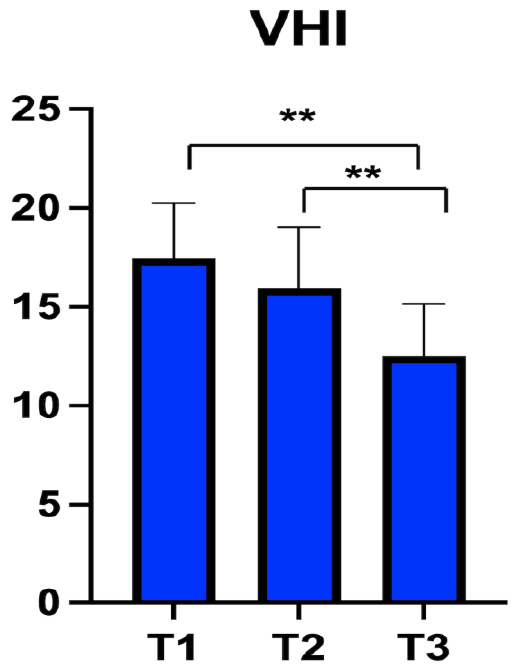
Figure 3. Voice Handicap Index-10 (VHI-10) score at three different observation points. The asterisks represent the statistically significative difference between evaluations (** p < 0.001).